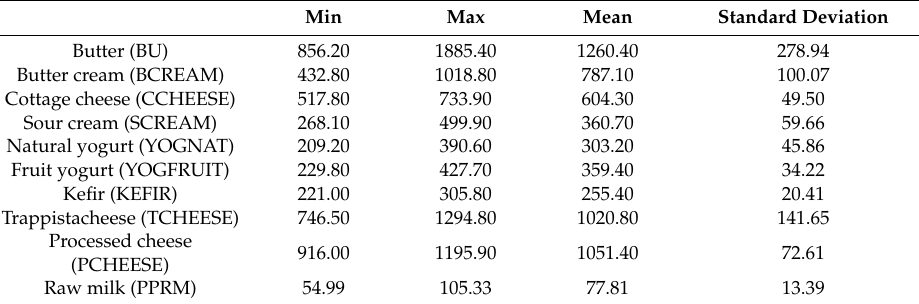
Table 1. Statistics of dairy product prices (in HUF / kg).